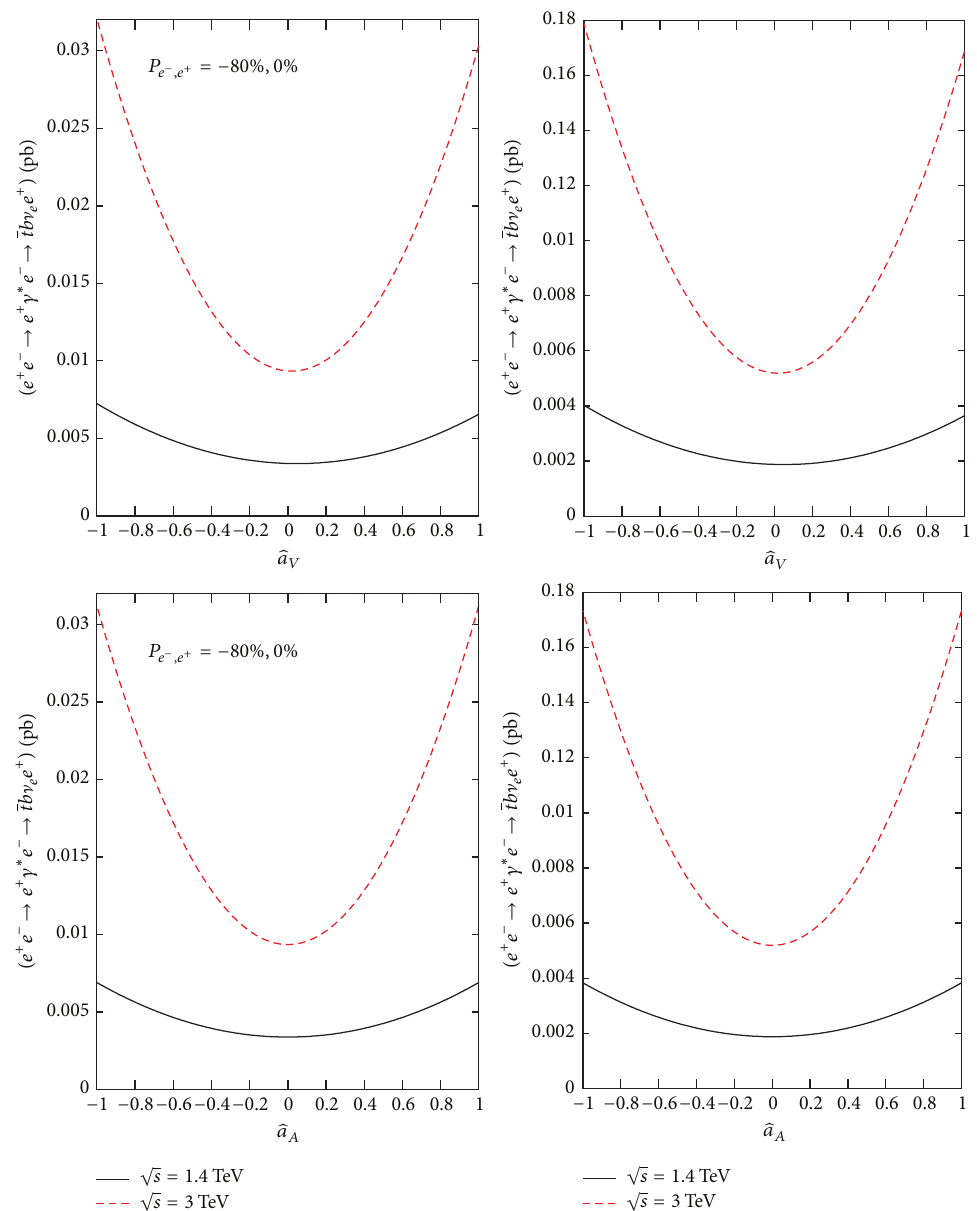
Figure 5: The integrated total cross section of the process 𝑒 + 𝑒 − → 𝑒 + 𝛾 ∗ 𝑒 − → 𝑡𝑏 ] 𝑒 𝑒 + ( 𝛾 ∗ is the Weizsacker-Williams photon) as a function of √𝑠 = 1.4, 3 TeV, 𝑄 2 = 2 GeV 2 and polarized and unpolarized ̂𝑎 ̂𝑎 𝑉 and 𝐴 with